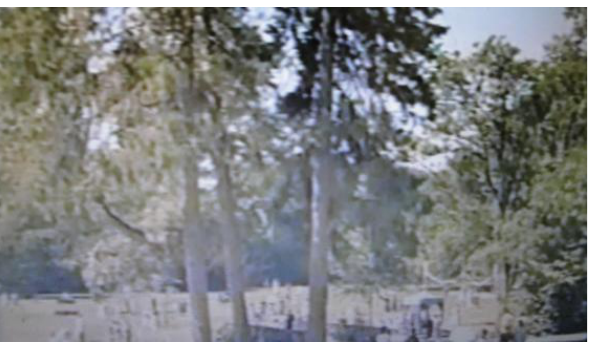
Figure 1: Scene of Benjamim (the arrival of the guests) shown in A gentle woman